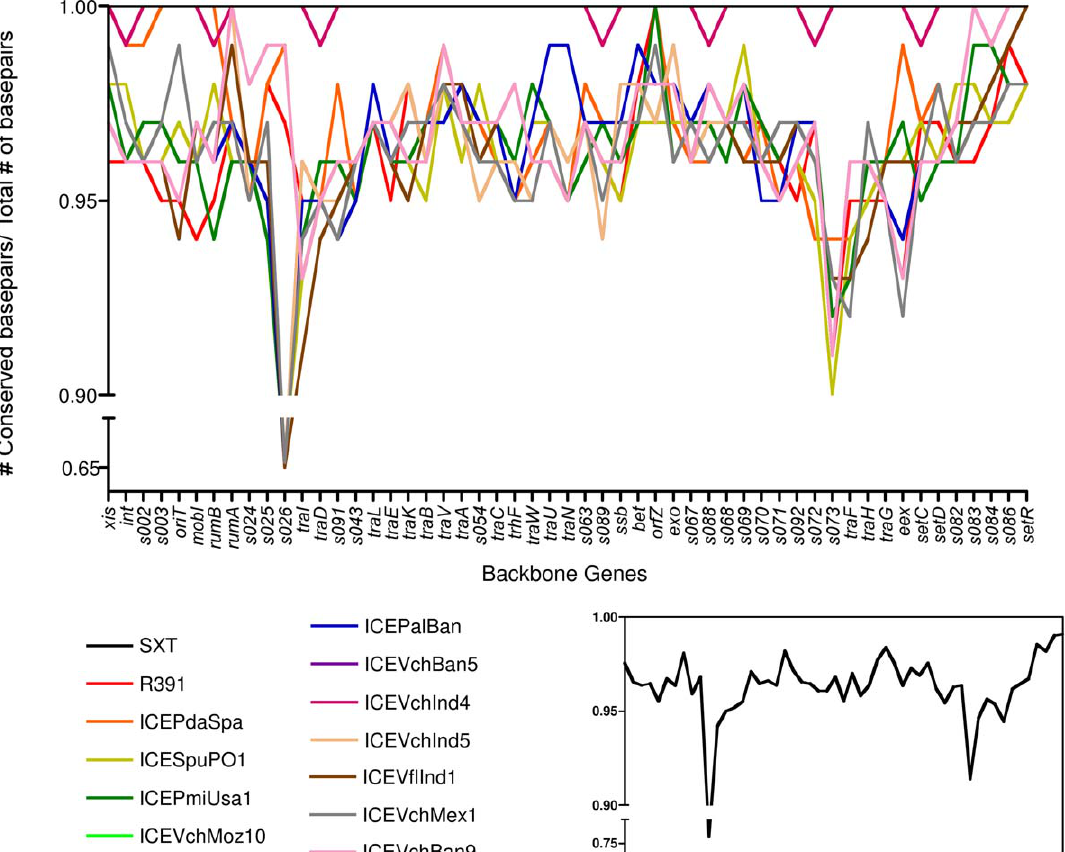
Figure 5. Variations in the nucleotide conservation of core ICE genes. The nucleotide sequence of each core gene from each ICE was compared to the corresponding sequence in SXT using pairwise BLASTn analyses to determine the percent identities. The average values for all of the ICEs, excluding SXT and ICE Vch Ind4, are shown in the inset.